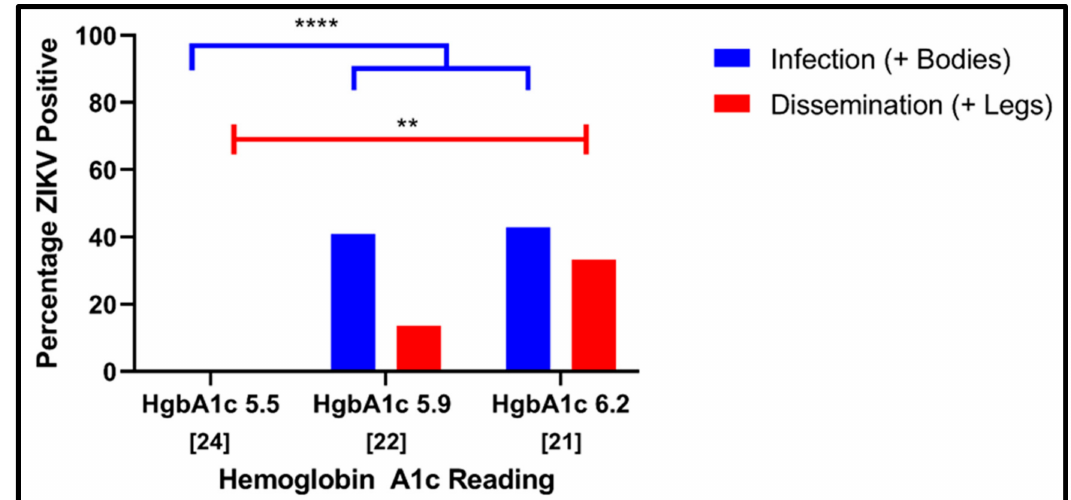
Figure 2. Effect of erythrocyte glycosylation on ZIKV infectivity of mosquitoes. ZIKV strain PRV- ABC59 was provided to Ae. aegypti (Galveston F5) in artificial bloodmeals at titers of 4.1 log 10 FFU/mL that were made with artificially glycosylated erythrocytes or mock-glycosylated erythrocytes (HbA1c 5.5). Blood-fed mosquitoes were incubated at 27 ± 1 ◦ C with 80 ± 10% relative humidity and a 16:8 light:dark cycle for fourteen days, at which point they were collected and analyzed for the presence or absence of ZIKV. Data are presented as percentages: 100 * [number of infected bodies (infection) or legs (dissemination) over total number of mosquitoes assayed in a given condition]. Numbers in brackets indicate sample sizes. * p < 0.05, ** p < 0.01, *** p < 0.001 and **** p <